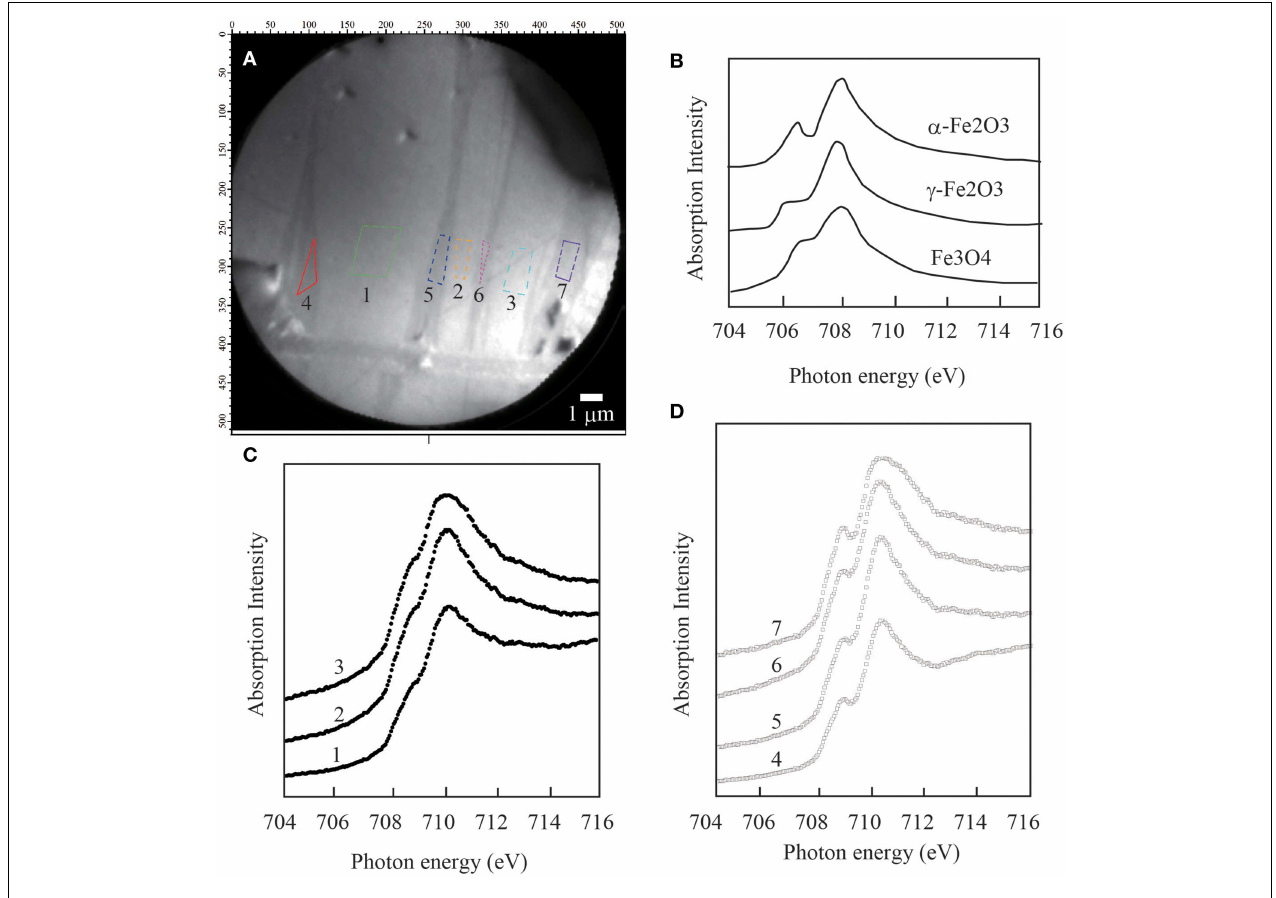
FIGURE 2 | X-ray Fe L 3 edge chemical analysis of the magnetite specimen. (A) X-ray absorption spectroscopy (XAS) image of areas 1–7. (B) XAS spectra of the reference bulk samples of hematite ( α -Fe 2 O 3 ), maghemite ( γ -Fe 2 O 3 ), and magnetite (Fe 3 O 4 ). (C) XAS spectra of areas